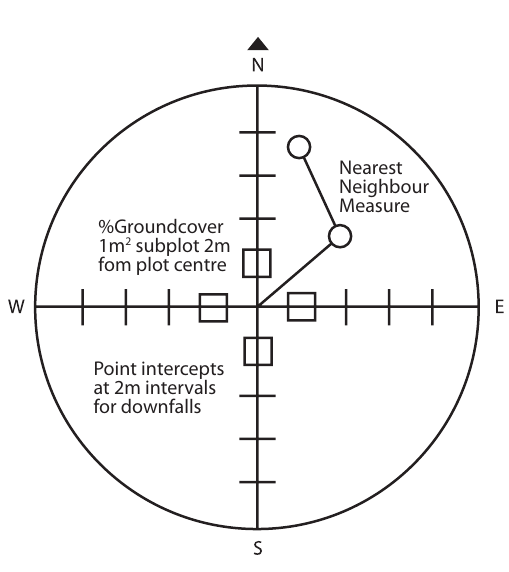
Fig. 3. Schematic of detailed vegetation measurements made within 10 m-radius sampling plots at cari- bou nursery sites and randomly chosen absence sites on lakes in Wabakimi and Woodland Caribou Provincial Parks, northern